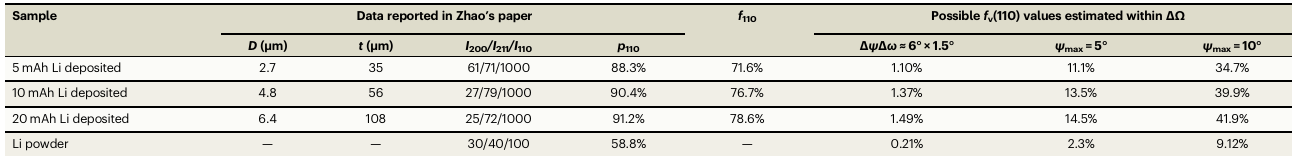
ThecorrespondingdataforLipowderarelistedforcomparisonandits I 200 /I 211 /I 110 valuesareknownfromPDF#15-0401.Theaveragesurfacegrainsize D ofeachLidepositanditsthickness t arealso listed.Thepossible f v (110)valueswithindifferentorientationspreads ΔΩ areestimatedbyusingEq.(2).Theanglewindowofdiffractometer ΔΩ w = π Δ ψ Δ ω /4,here Δ ψ and Δ ω inunitofradianarethe